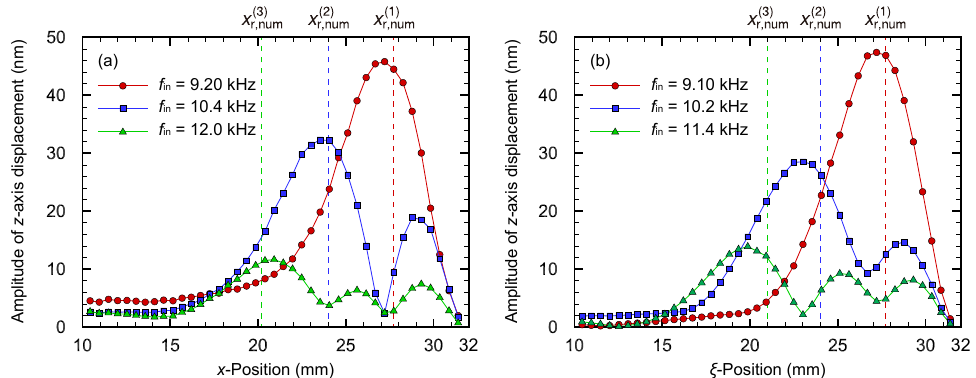
Figure 6. Experimentally obtained oscillation amplitude distribution in the x -axis direction of ( a ) the trapezoidal and ( b ) curved membrane devices, where the oscillation is induced with each resonance frequency at the resonance positions. The dashed line indicates the resonance positions in the numerical analysis. For each eigenmode, the positions where the amplitude is maximum, i.e., the resonance positions, are observed, and the results correspond well with the numerical analysis. The amplitude distributions for the trapezoidal and curved devices are in good agreement, suggesting that the curving device has a small effect on the oscillation characteristics of the trapezoidal membrane device.